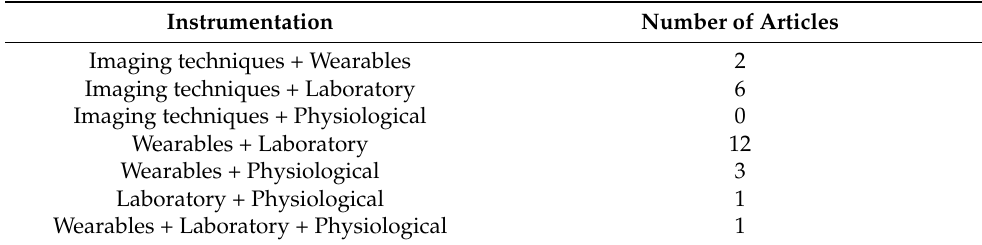
Table 1. Combined approaches of different technologies and number of articles in which they are reported.